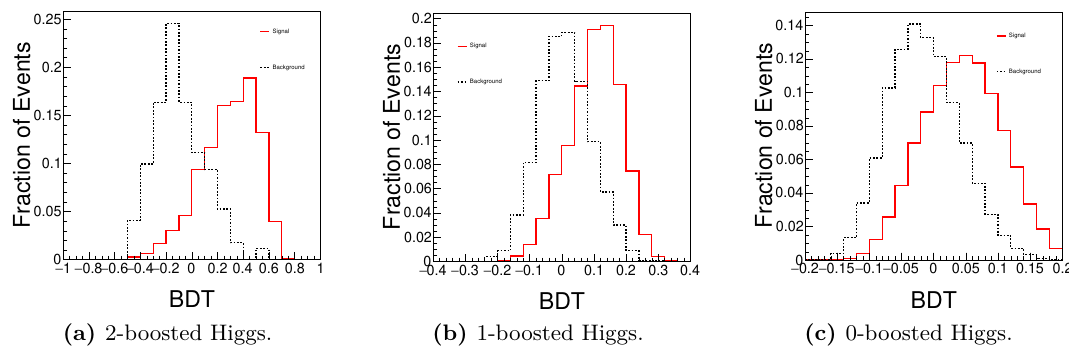
(c) 0-boosted Higgs. Figure 2 . The response of the discriminants to the SM signal and background at 14 TeV LHC with (a) 2-boosted events, (b) 1-boosted events, and (c) 0-boosted events. 2-boosted Higgs 1-boosted Higgs